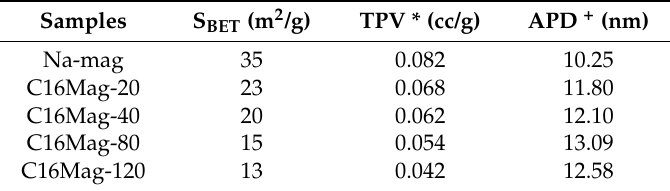
Table 2. Microtextural properties of Na-magadiite and its organo-derivatives prepared with different initial C16TMABr loading solutions.